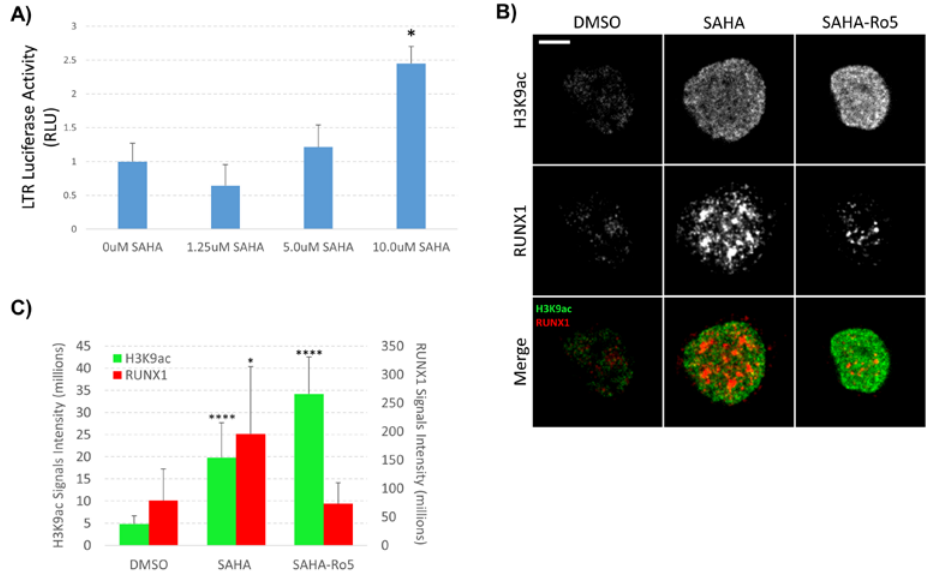
Figure 2. Effect of SAHA and Ro5-3335 treatment on RUNX1 expression in the nucleus. ( A ) LTR-driven luciferase activity was determined post-treatment with the indicated concentrations of SAHA; ( B ) nuclei were isolated from TZMbl cells treated with 1µM SAHA and 50µM Ro5-3335 and stained for H3K9ac (green) and RUNX1 (red). Spinning disk confocal microscopy was used for imaging using 100X oil objective. Images of bright field and nuclear fluorescence were captured using a high-speed camera. ( C ) Localize software was used to measure signal intensity in the collected images. Scale bars: 5 µm. * P ≤ 0.05, *** P ≤ 0.001.